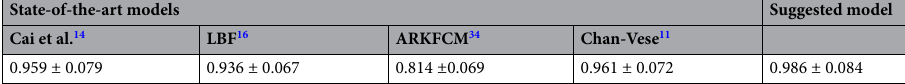
Table 2. The Sørensen–Dice similarity for the Cai et al. 14 , LBF 16 , Chan-Vese 11 , ARKFCM 34 and of our suggested approach on 10 dissimilar